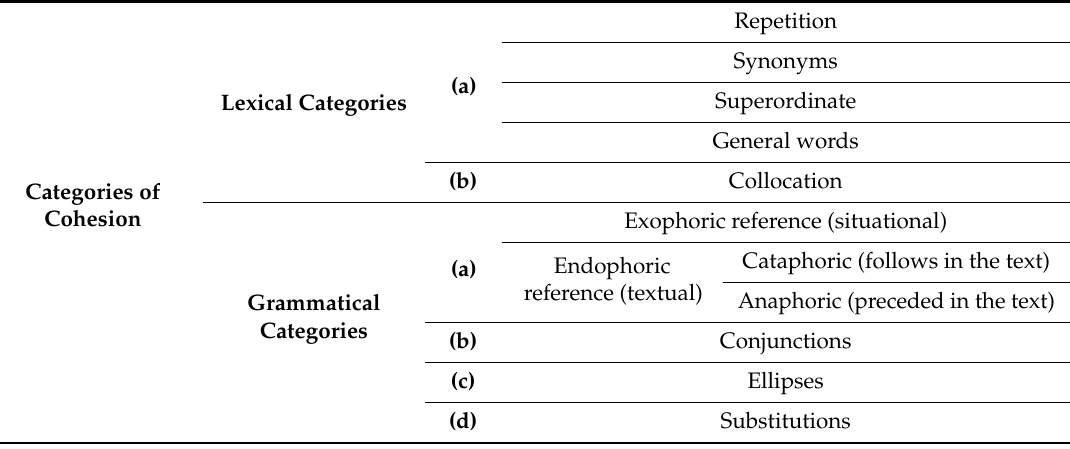
Table 1. Categories of